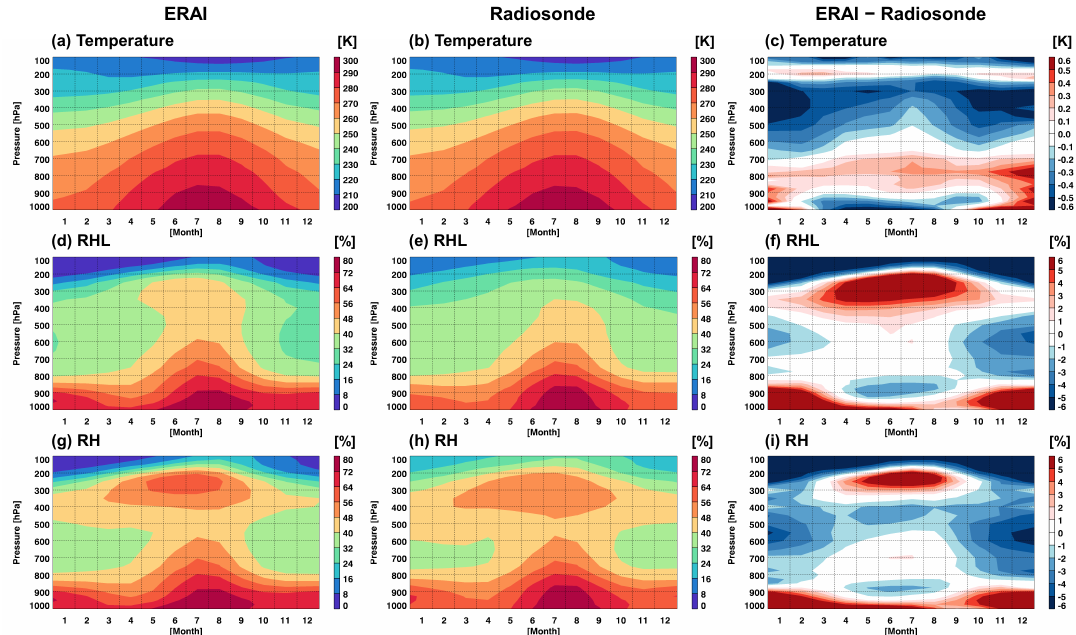
Figure 3. Monthly climatology profiles of ( a , b ) temperature, ( d,e ) relative humidity with respect to liquid (RHL), and ( g,h ) relative humidity with respect to ice (RHI) based on ERAI (left) and radiosonde (middle) datasets. The differences between ERA-Interim (ERAI) and radiosonde data are given in the right panel ( c,f,i ). The X-axis denotes each month from January to December.